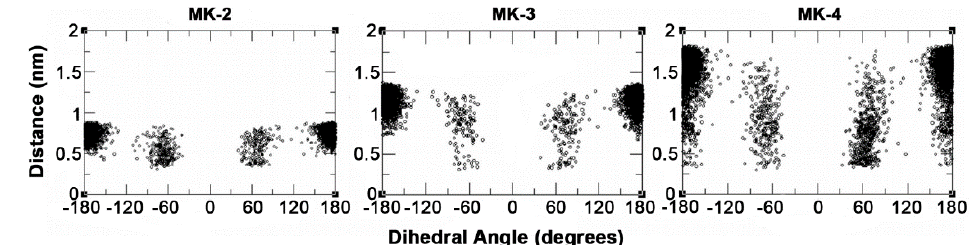
Figure 11. Plots of the distance between the terminal CH 3 groups in MK-2, MK-3 or MK-4 to the middle of the center C-C bond of the naphthoquinone headgroup, d(CT-H), as obtained when the dihedral angle is changing as the rotation around the C11-C12 bond takes place.